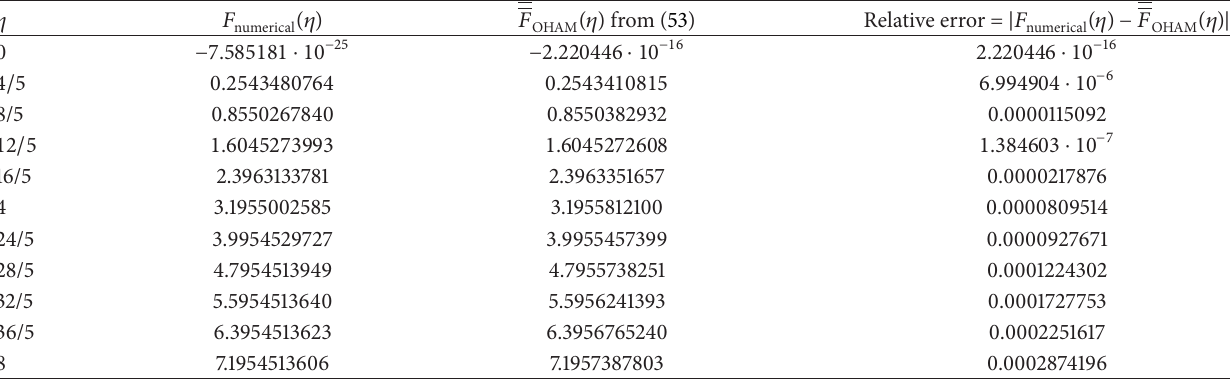
Table 5: Comparison between OHAM results given by (53) and numerical solutions for 𝛽 = 1/2 . 𝜂